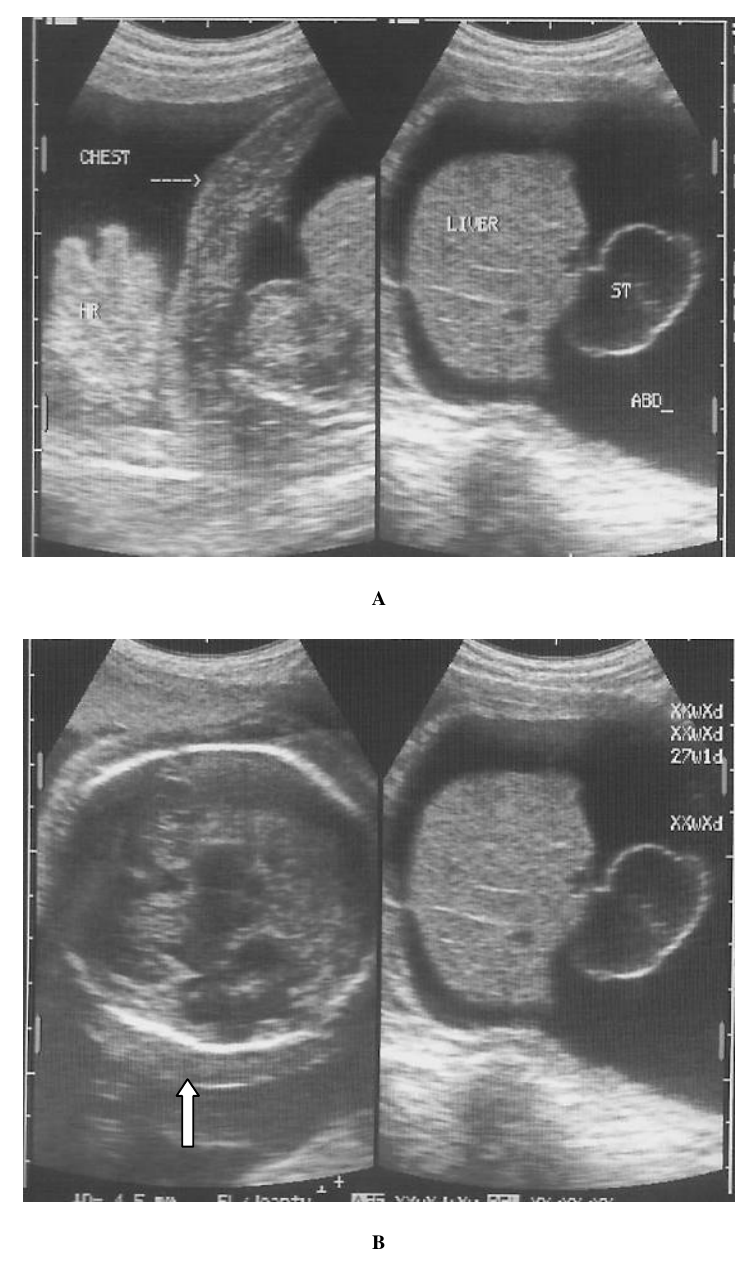
FIGURE 1. Sonogram of a 27-week-old male fetus with NIHF. (A) Longitudinal scans of fetal chest (left) and abdomen (right) showing hydrothorax, edematous diaphragm (arrowed), ascites, and the liver, with fluid-filled blind-ended stomach (ST). (B) Axial scan of the skull and longitudinal abdominal scan of the same fetus. Note the scalp edema (arrowed) and